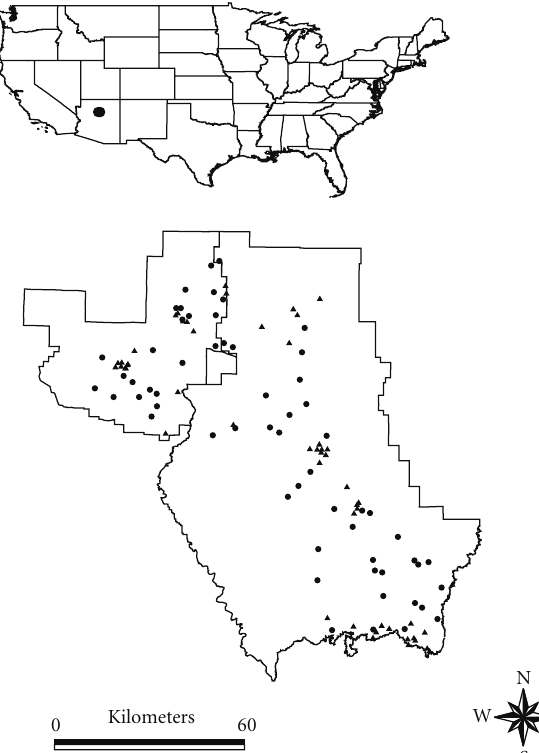
Figure 1: Location of the study area (black box, top) in northern Arizona, USA, and locations of snag-monitoring plots within the study area (bottom). Plots were located in the Kaibab (left) and Coconino (right) National Forests, north-central Arizona. Plots in ponderosa pine forest ( n = 60) are indicated by circles, plots in mixed-conifer forest ( n = 53) by